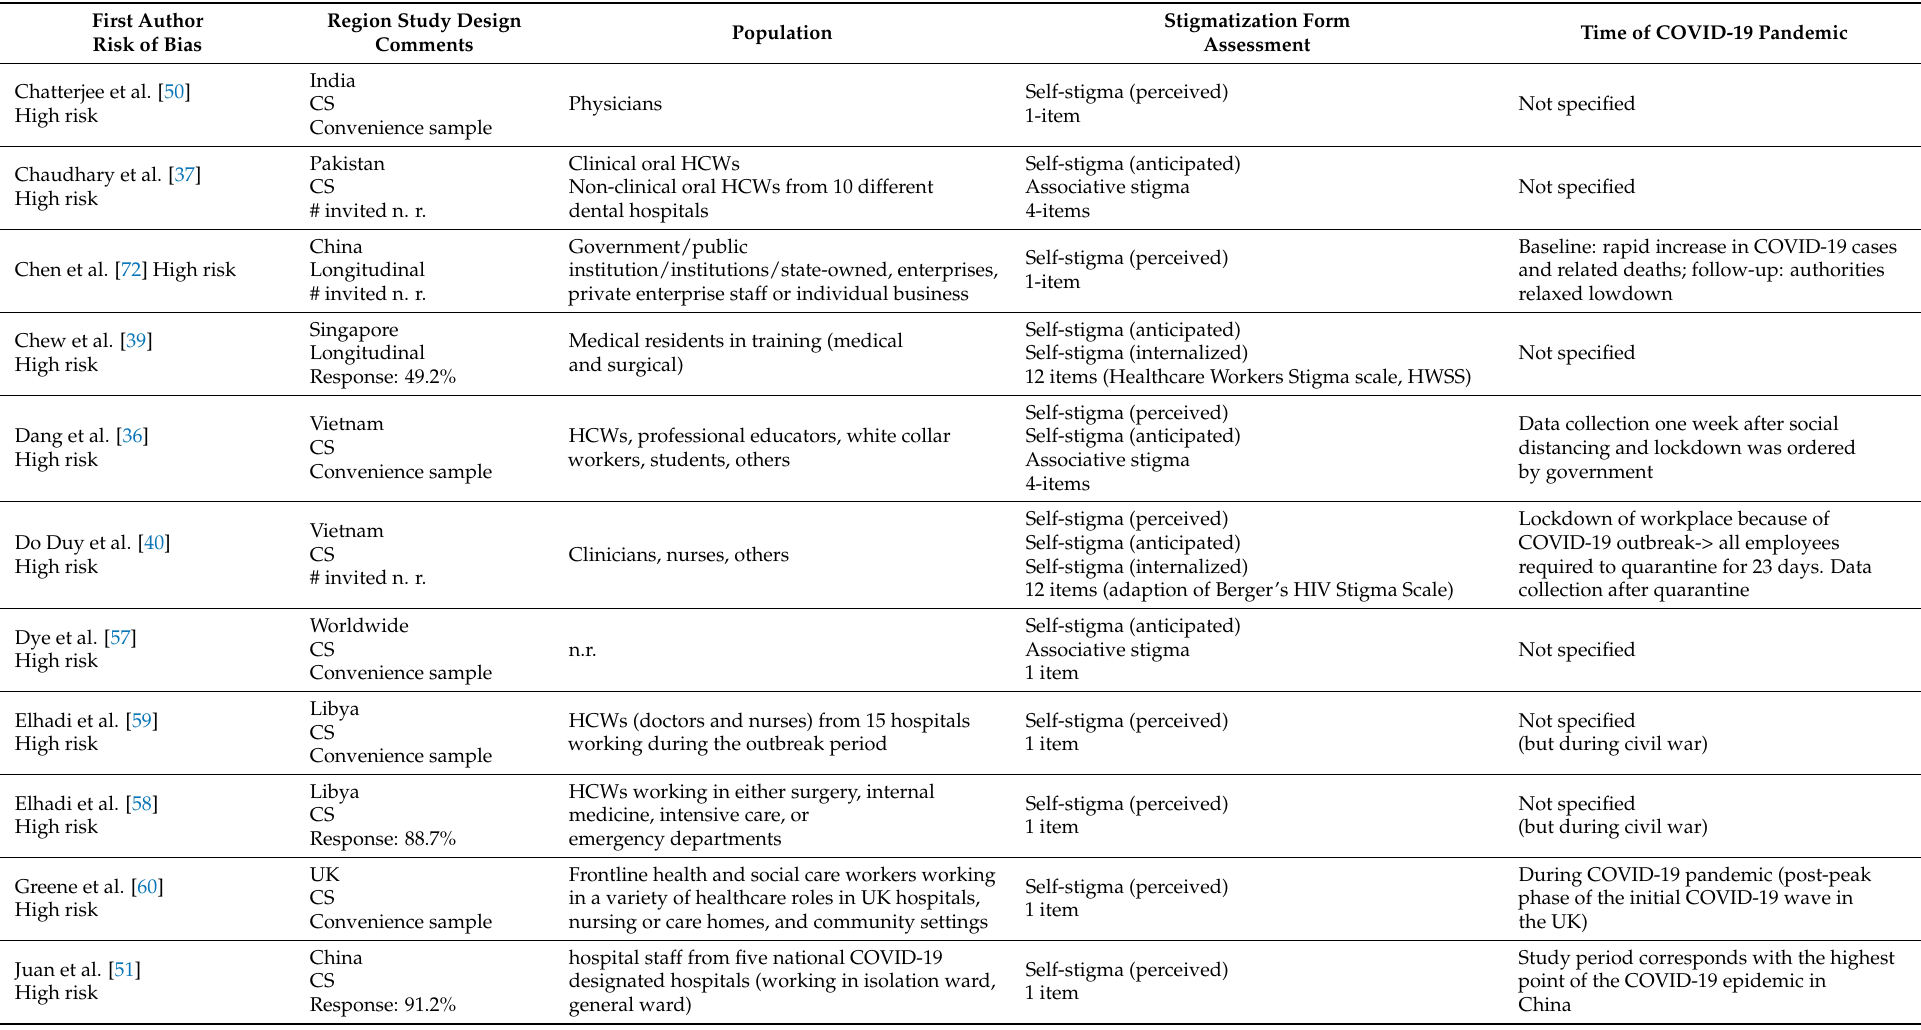
Table 4. Summary of included quantitative